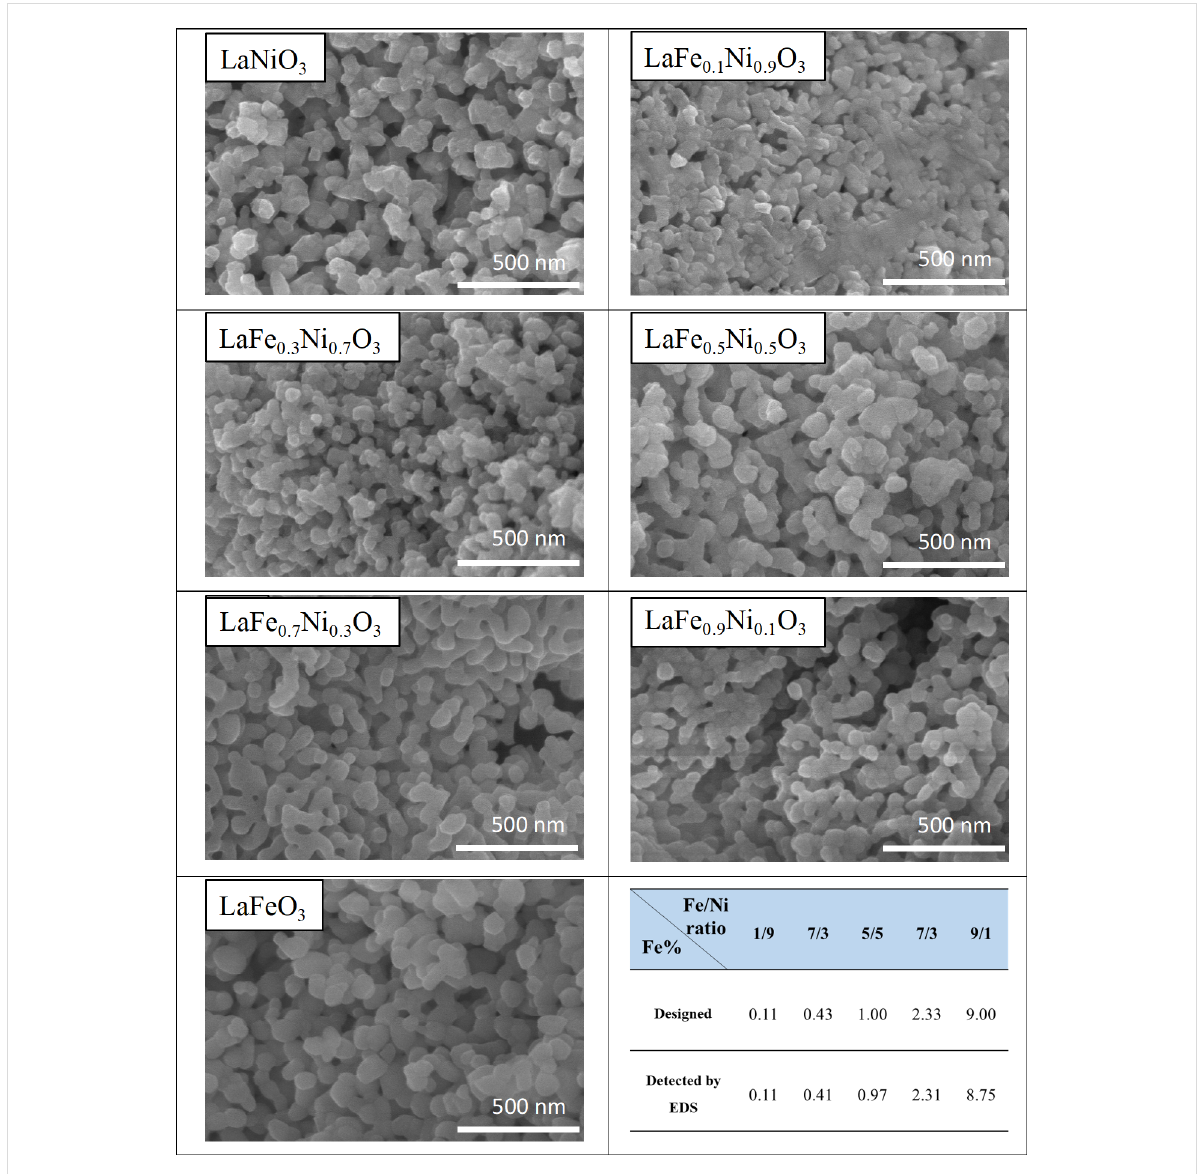
Figure 7: The FESEM images of LaFe x Ni 1 − x O 3 prepared at pH 0 (at the magnification of 100,000×).